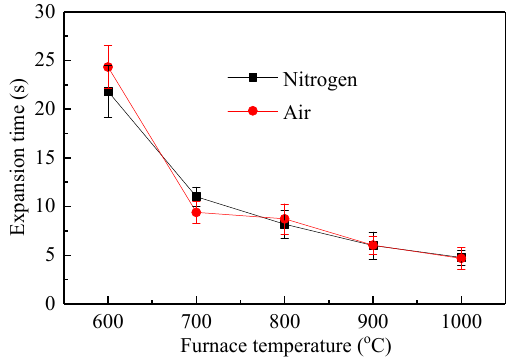
Figure 10. Swelling time vs. furnace temperature.